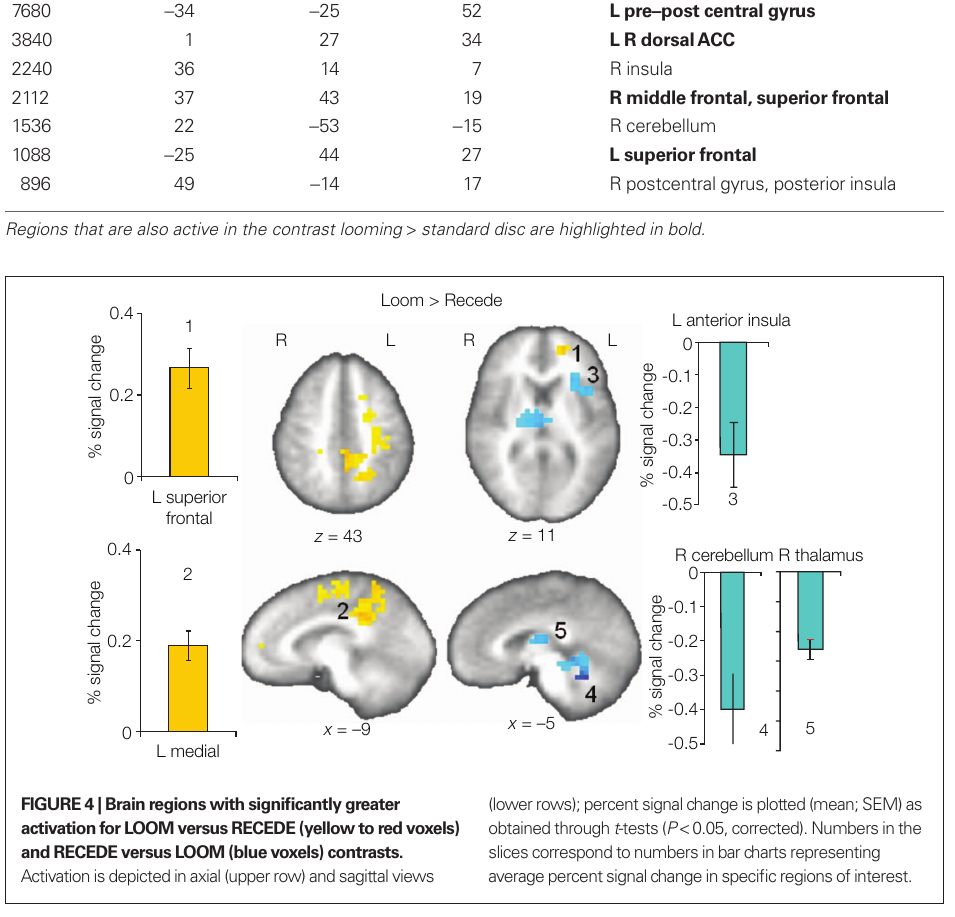
(lower rows); percent signal change is plotted (mean; SEM) as obtained through t -tests ( P < 0.05, corrected). Numbers in the slices correspond to numbers in bar charts representing average percent signal change in specific regions of interest.